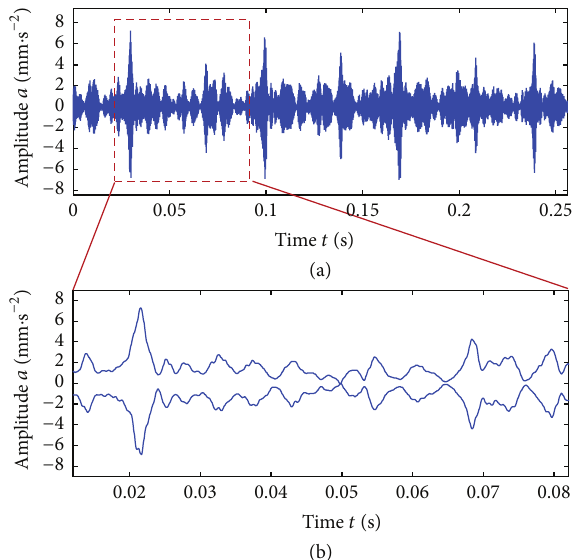
Figure 7: The wavelet coefficient at selected subband and its envelope under normal condition.